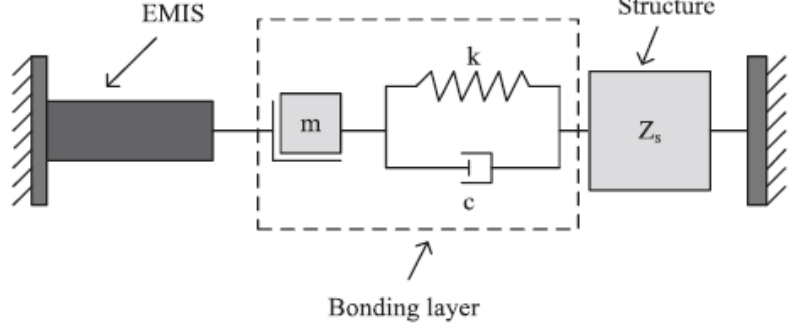
Figure 56. The modified one dimensional EMI model showing the bonding layer between the EMI sensors and the pipeline. Reprinted from Smart Materials and Structures, Volume 26, Number 10, Zuo, C.; Feng, X.; Zhang, Y.; Zhou, J. Year 2017 with permission from IOP Publishing Limited [144]. However, the low curie temperature of piezoelectric transducers renders the EMI method unsuitable for the monitoring of pipelines carrying high-temperature